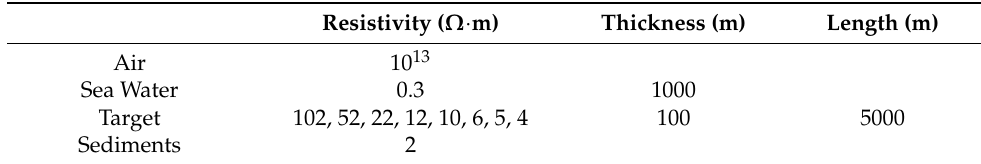
Table 1. Model parameters of the marine CSEM method